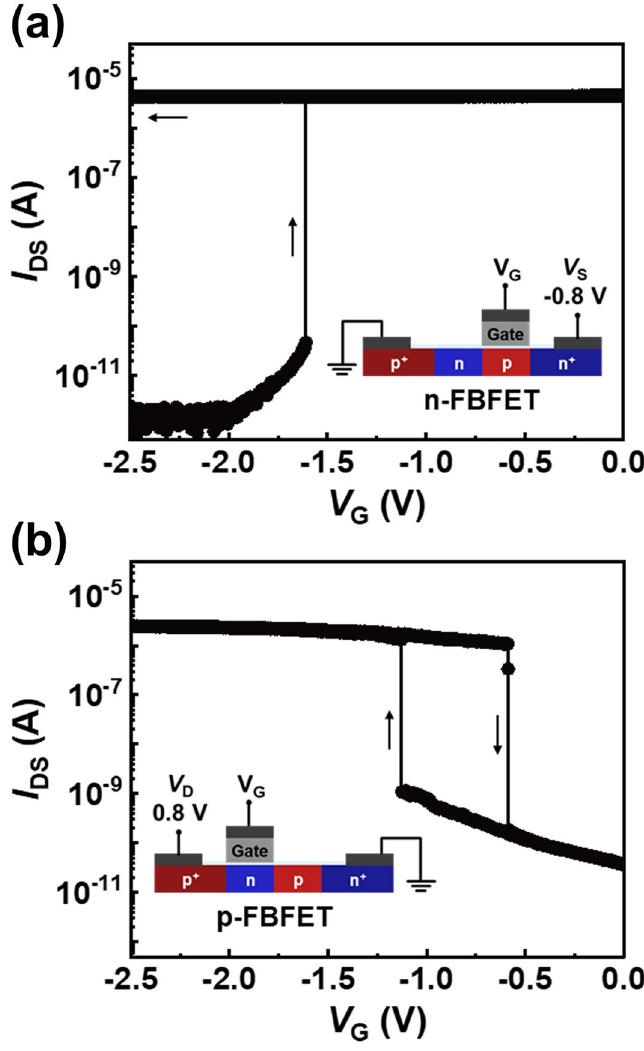
Figure 2. Representative transfer characteristics of ( a ) n- and ( b )